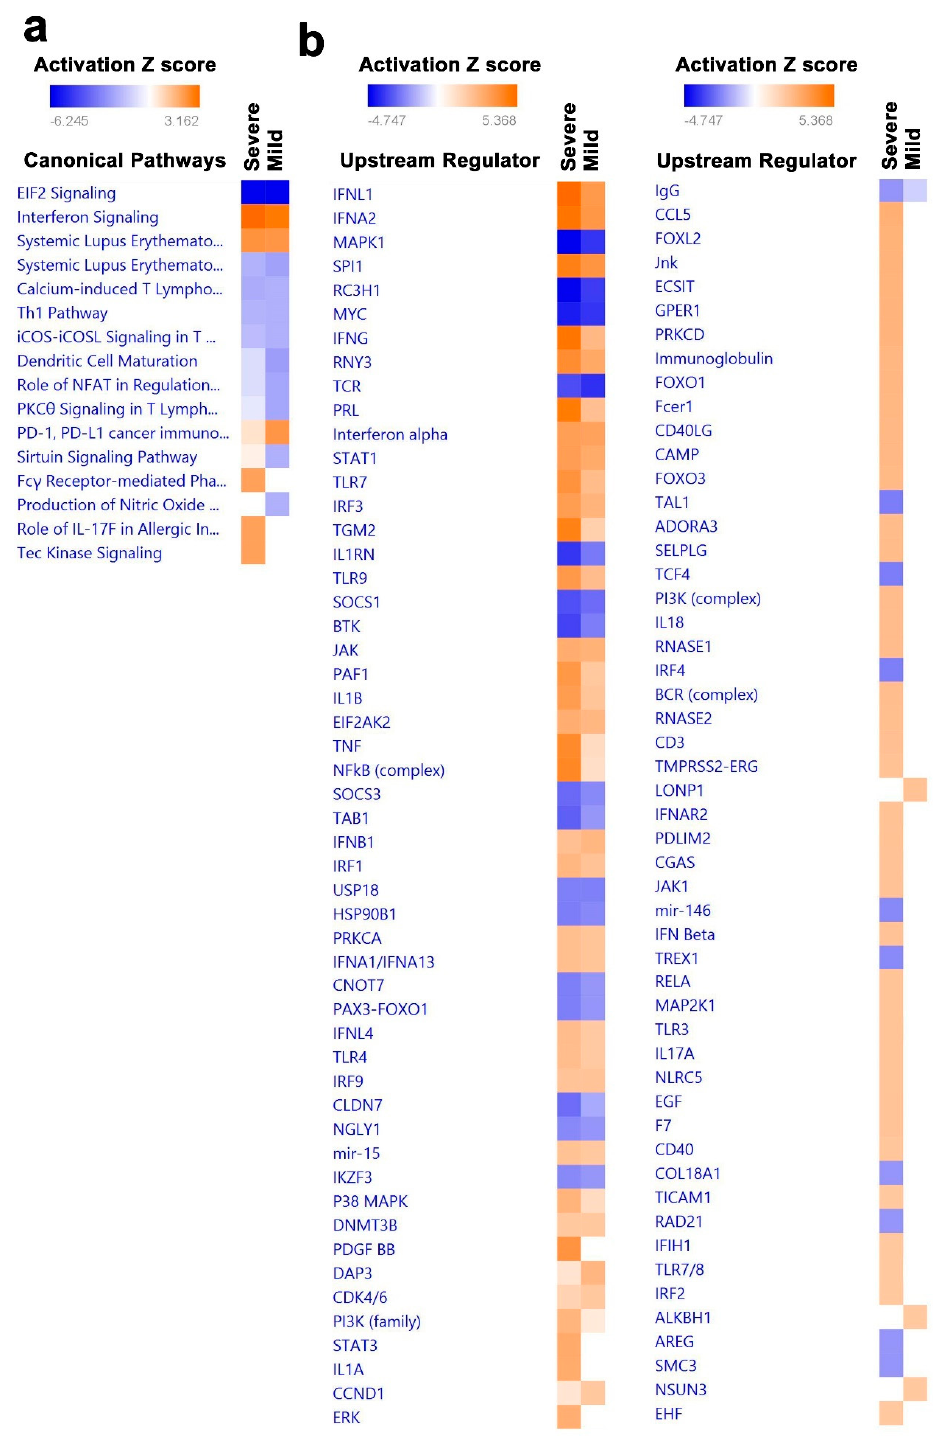
Figure 6. Identification of canonical pathways and upstream regulator networks associated with severe and mild COVID-19. Di ff erentially expressed genes in patients with severe vs. control and mild vs. control COVID-19 were subjected to canonical and upstream regulator analysis using ingenuity pathways analysis (IPA). ( a ) Comparative analysis of significantly altered canonical pathways in mild- and severe-COVID-19 BAL transcriptome data. ( b ) Comparative analysis of significantly altered upstream regulatory networks in mild- and severe-COVID-19 BAL transcriptome data. Red indicates activated, while blue indicates suppressed pathways. Activation Z score is depicted according to the color